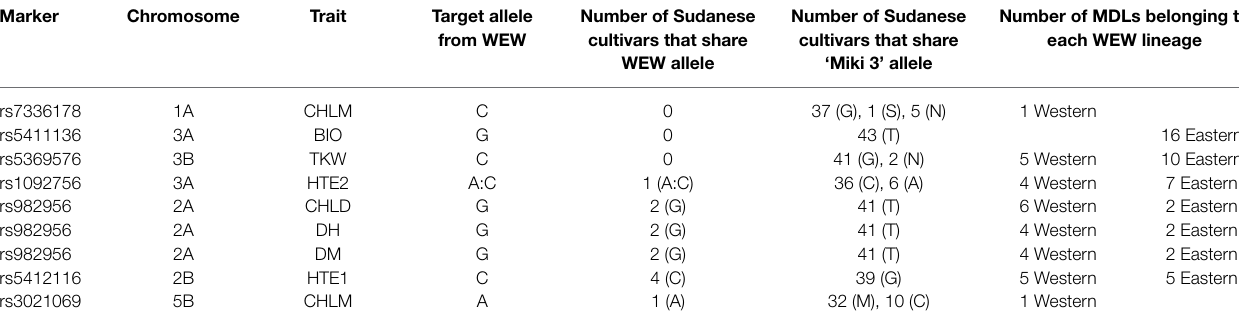
TABLE 3 | Investigation of wild emmer wheat (WEW) alleles on Sudanese cultivars for some traits showed positive SNP alleles from WEW. Marker Chromosome Trait Target allele